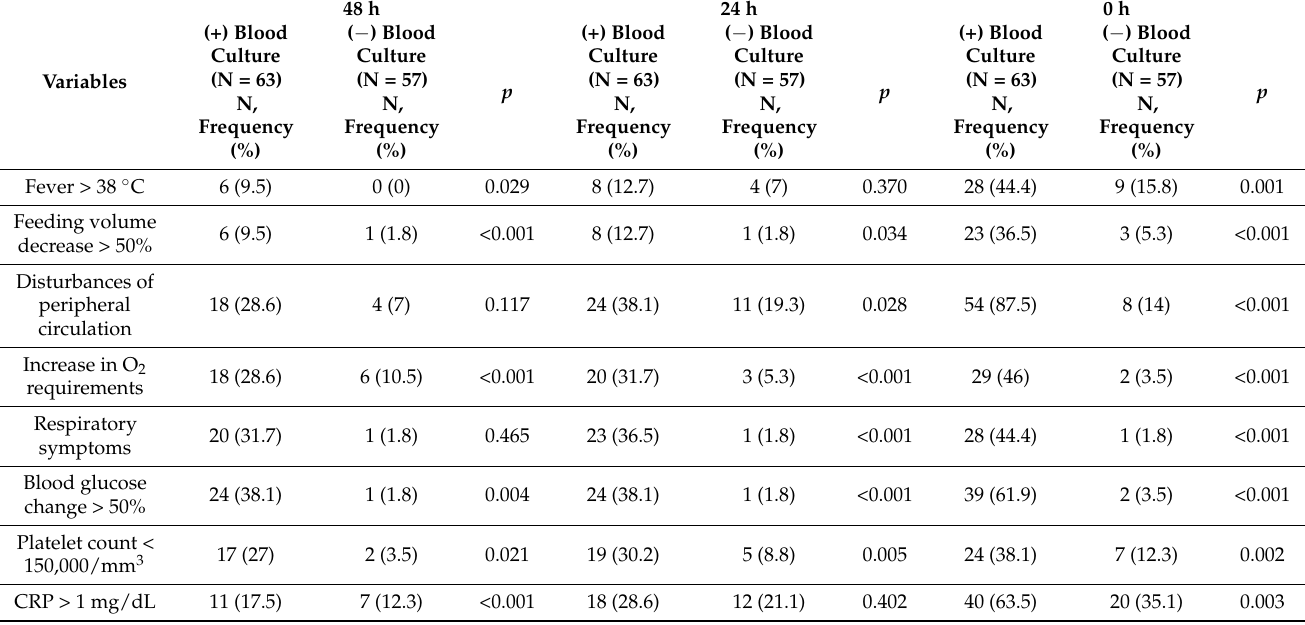
Table 3. Retrospective study; each variable of the Sepsis Prediction Score in positive and negative blood culture neonates, 48 h prior, 24 h prior and on the blood culture